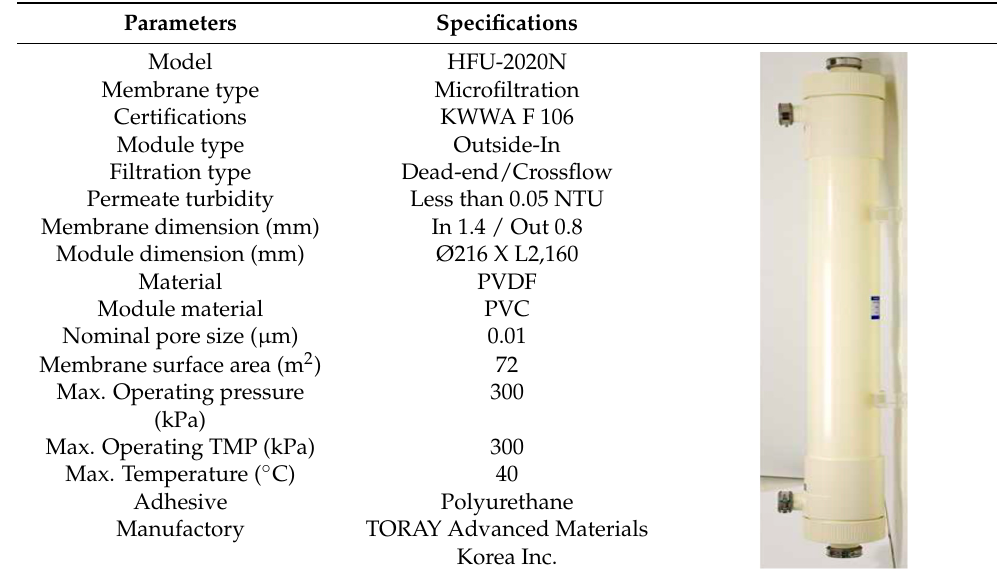
Table 2. Specifications of the membrane module (HFU-2020N, Toray Advanced Materials Korea Inc., Seoul, Korea).